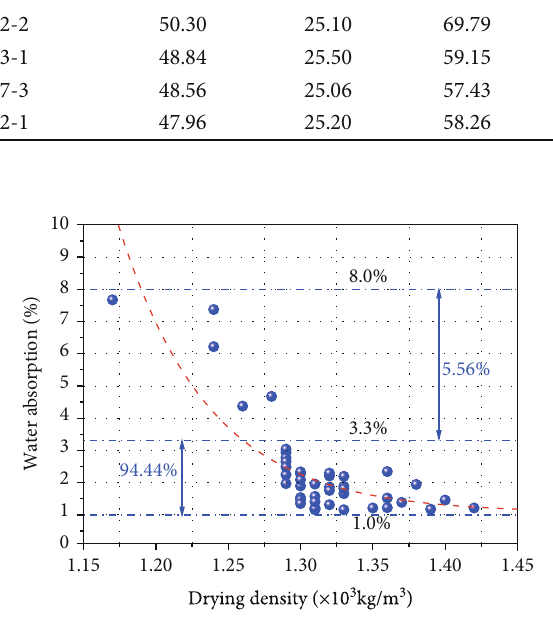
Figure 3: Relationship between saturated water absorption and density of coal